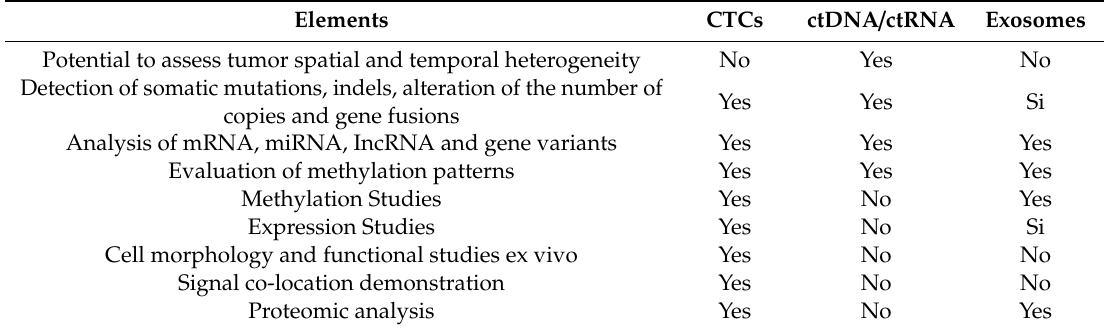
Table 1. Applications of the elements of circulating tumor cells (CTCs), tumor nucleic acids (ctDNA / ctRNA) and exosomes. Adapted from Siravegna et al. (2018) [7]. Elements CTCs ctDNA / ctRNA Exosomes Potential to assess tumor spatial and temporal heterogeneity No Yes No Detection of somatic mutations, indels, alteration of the number of Yes Yes Si copies and gene fusions Analysis of mRNA, miRNA, IncRNA and gene variants Yes Yes Yes Evaluation of methylation patterns Yes Yes Yes Methylation Studies Yes No Yes Expression Studies Yes No Si Cell morphology and functional studies ex vivo Yes No No Signal co-location demonstration Yes No No Proteomic analysis Yes No